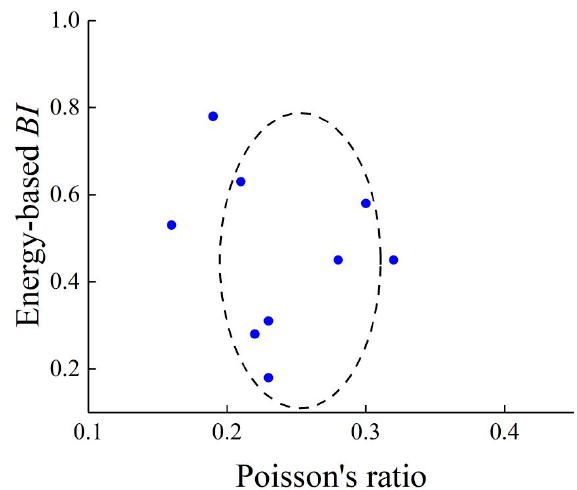
Figure 8. The relationship between brittleness index and Poisson’s ratio.